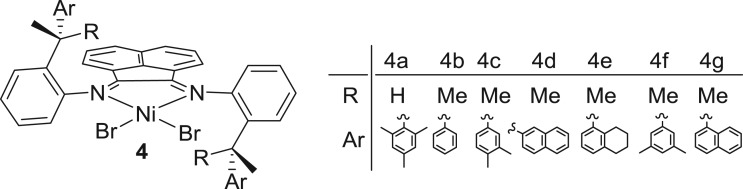
C2-symmetric α-diiminoacenaphthene-nickel pre-catalysts.